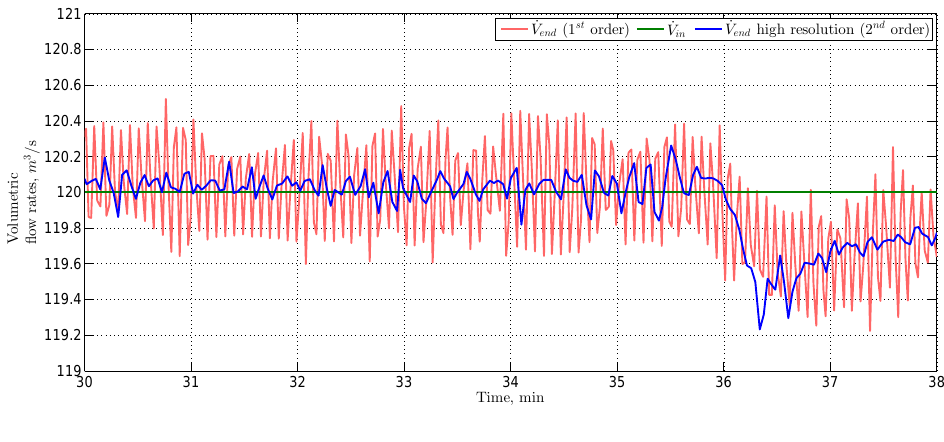
Figure 6: Zoomed plot of the volumetric flow rate in the last cell (ode23 solver).